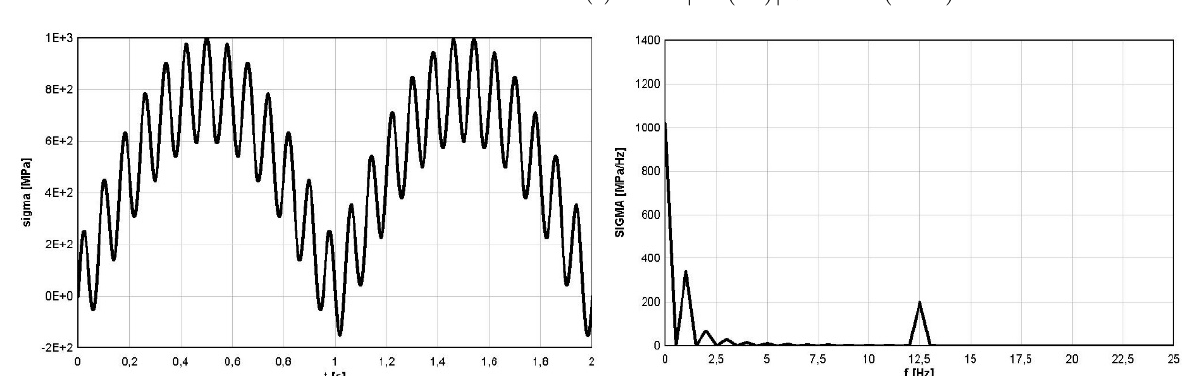
Figure 4. Time history of the function (8) ( left ) and its FFT form ( right ). Identified cycles based on the applied spectral method are summarized in Table 1 (RAINFLOW denotes results obtained using the rainflow method and FOURIER those obtained by application of the Fourier transform and the direct spectral method). It